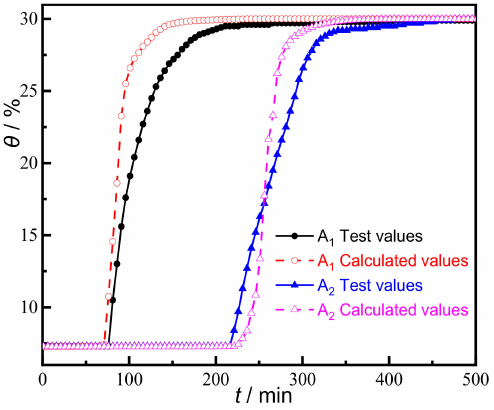
Figure 6. Comparison of water content test value and calculated